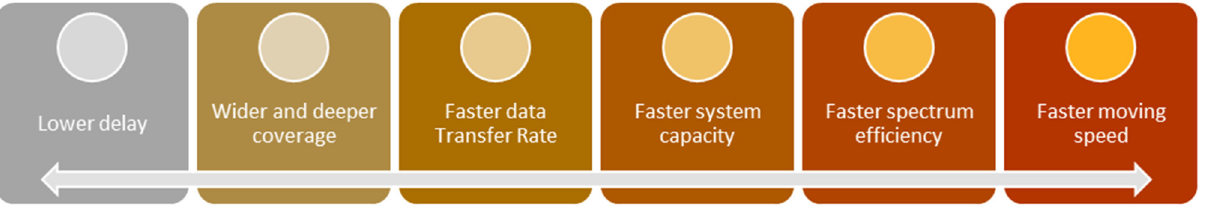
Figure 2. Different aspects that are covered by 6G.